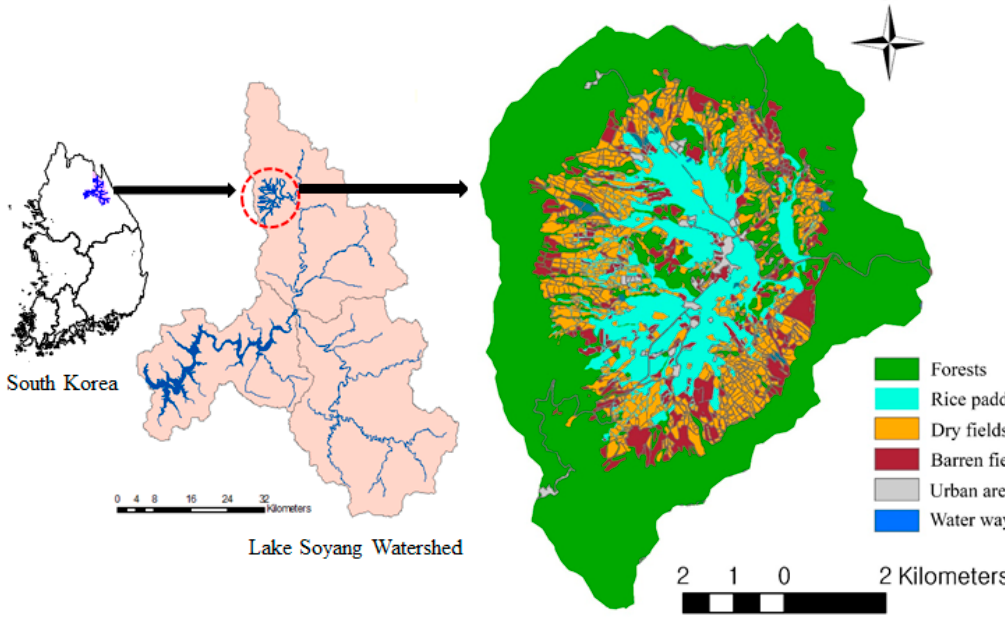
Figure 1. Location of the Haean watershed in eastern Korea and map showing the land use in the mixed-use watershed [4,12]. Table 1. Characteristics of the Haean watershed [4,12].